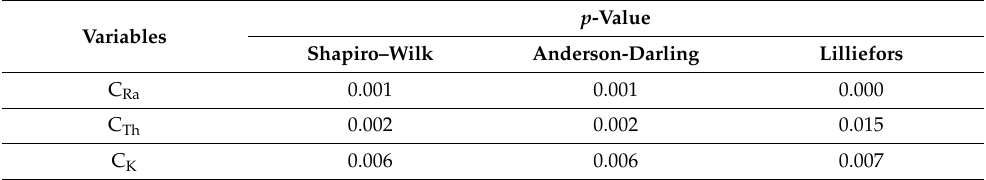
Table 6. p -value results of different statistic tests used to verify the normal distribution of data. p -Value Shapiro–Wilk